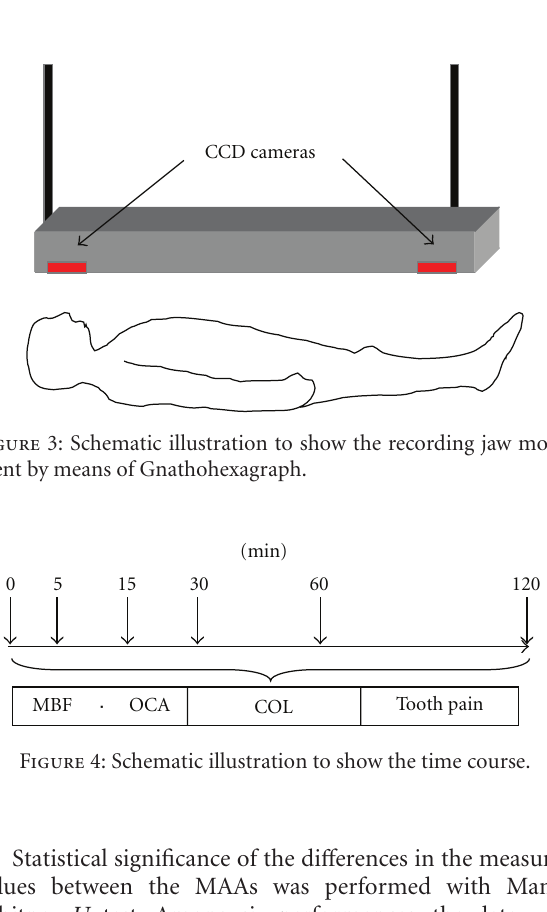
Statistical significance of the di ff erences in the measured values between the MAAs was performed with Mann- Whitney U test. Among six performances, the data were statistically analyzed using analysis of variances (ANOVA) and the subsequent pairwise comparisons. P values less than 0.05 were considered